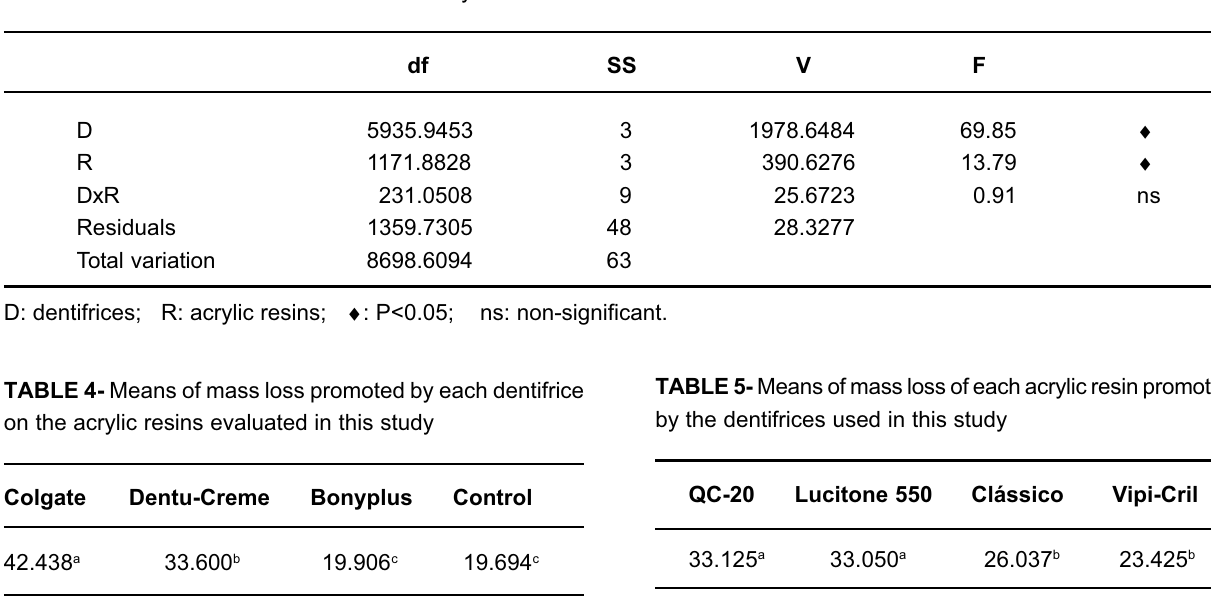
TABLE 3- ANOVA results for mass loss of acrylic resins